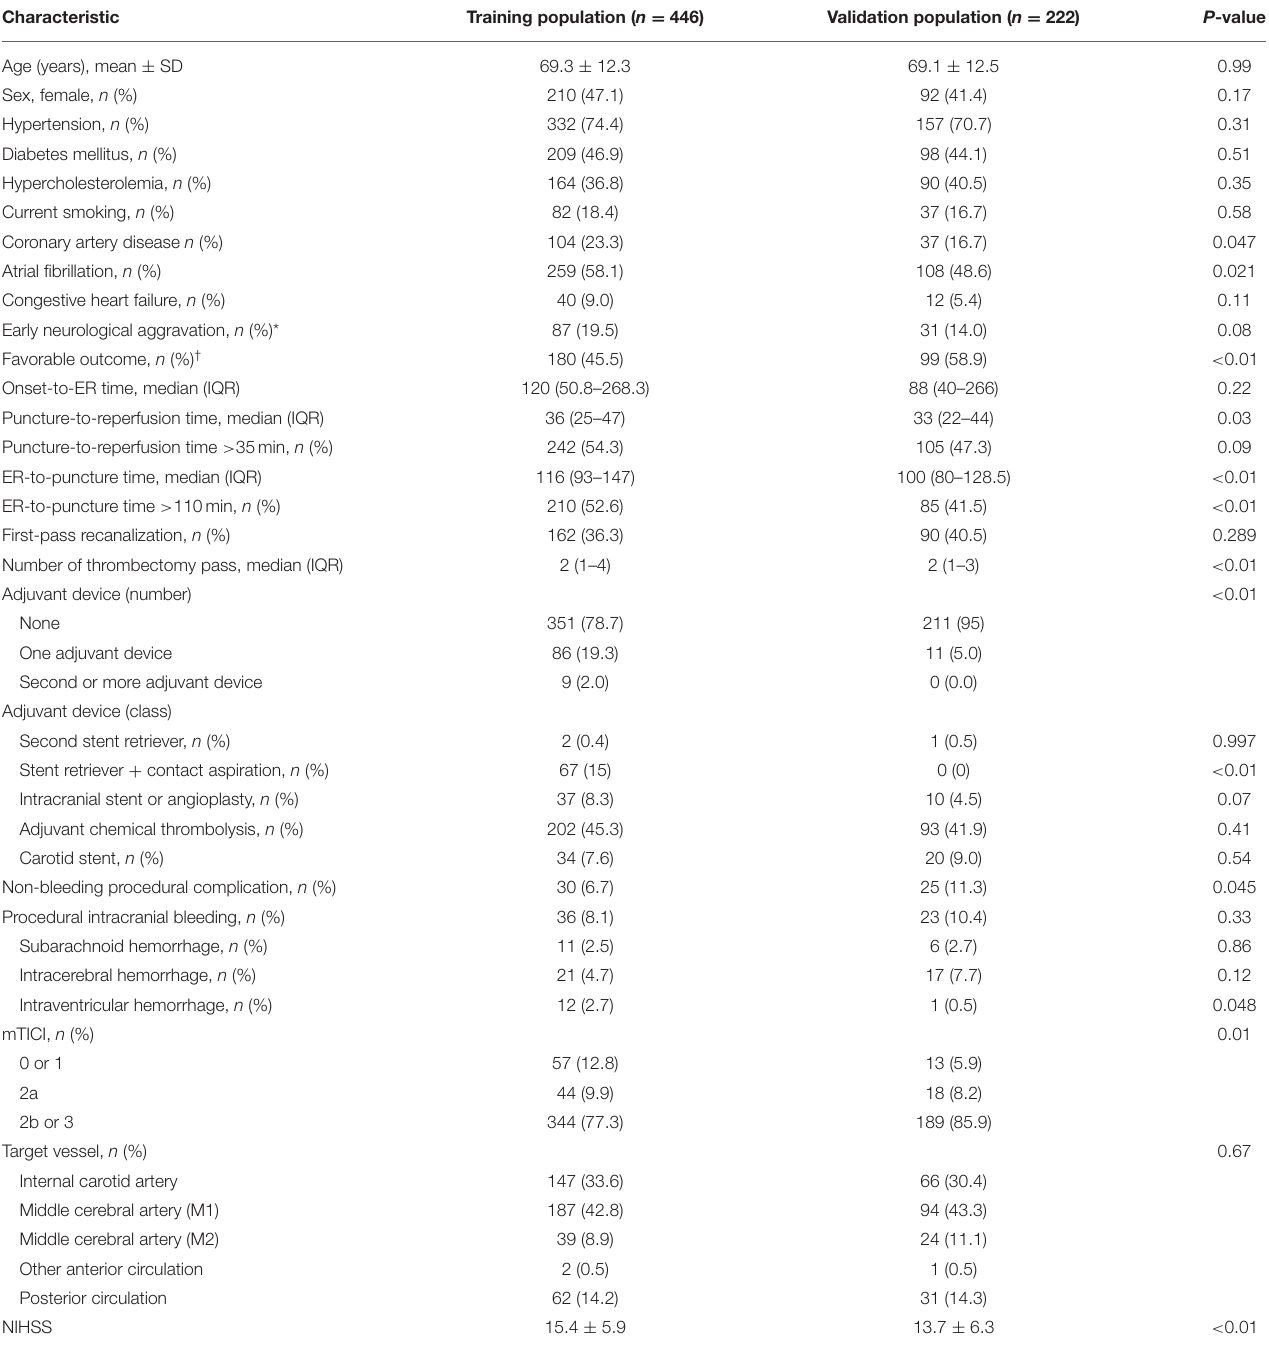
TABLE 1 | Baseline characteristics of the training and validation